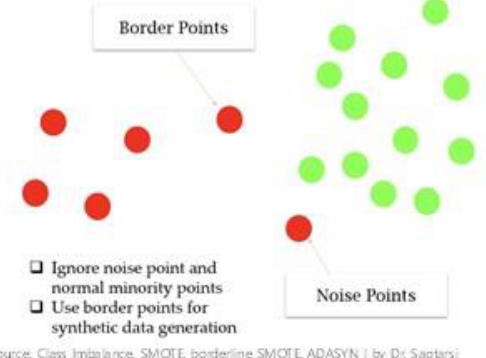
Figure 4. Working procedure of Borderline-SMOTE.